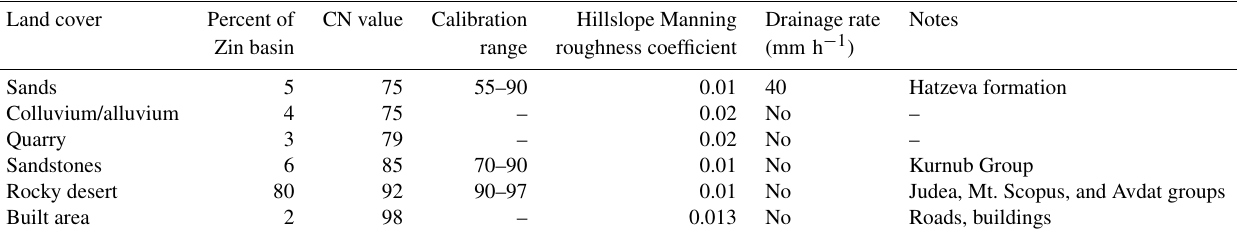
Table A1. Properties used for the GB-HYDRA model. Land